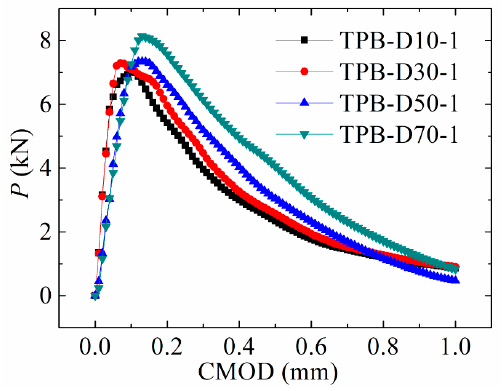
Figure 7. P- CMOD curves of the beams with different preset crack positions.